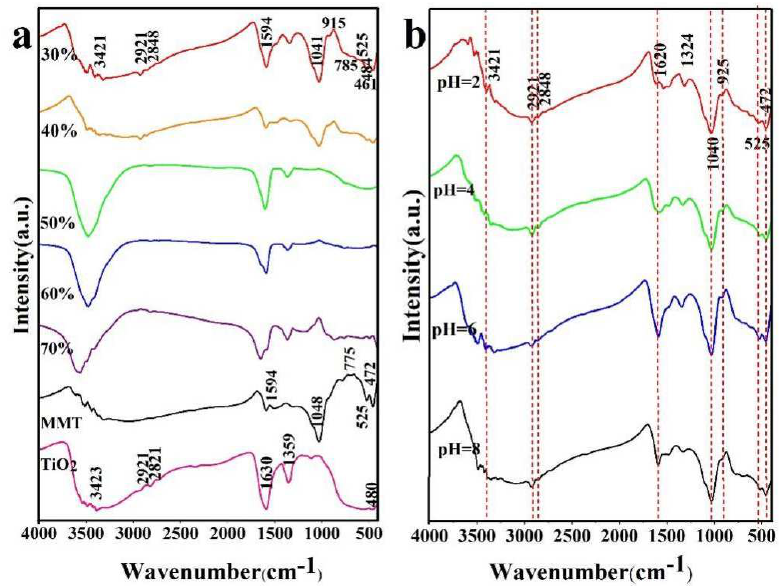
Figure 5. Fourier transform infrared spectra of TiO 2 -montmorillonite (MMT) composites prepared using ( a ) different TiO 2 /MMT mass ratios at a reaction temperature of 160 °C, a dwelling time of 24 h, and a TiO 2 mass ratio of 30 wt%.